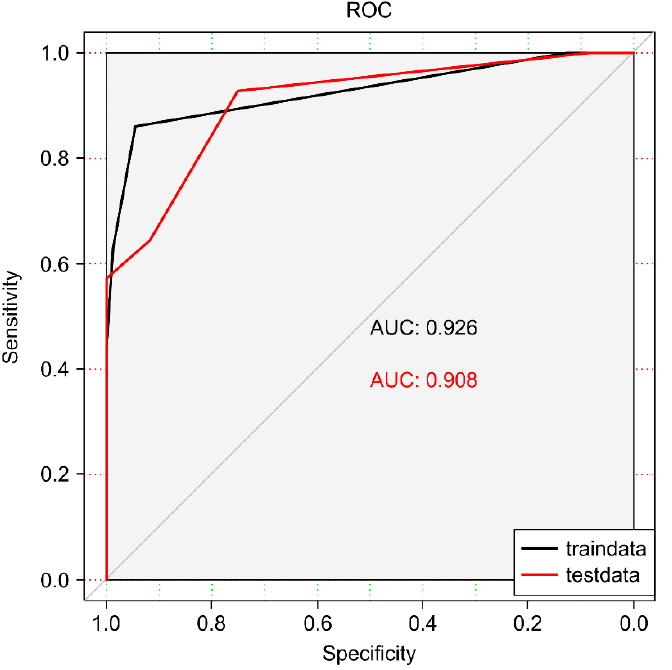
Figure 4. Importance of the features for the ten variables in Adaboost classification.